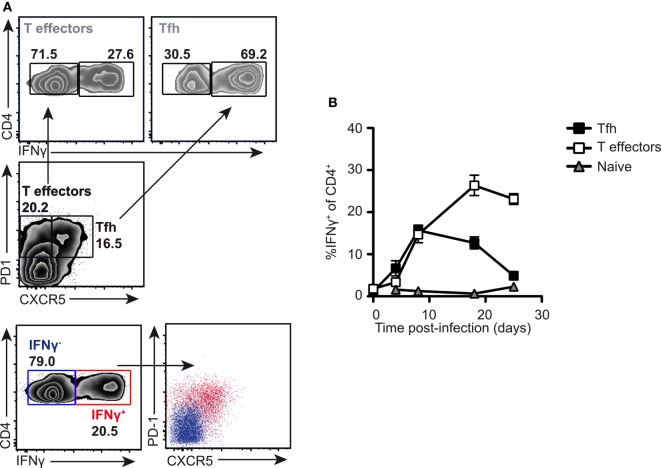
PD1lo T follicular helper cells (Tfh)-like function as effector cells early in response to Salmonella. Analysis of intracellular IFN-γ production in normal mice infected with SL3261. (A) Intracellular staining for IFNγ was performed following PMA and ionomycin stimulation on splenocytes from SL3261-infected animals at day 7. Cells were gated on Tfh (PD1+CXCR5+) versus T effectors (PD1+CXCR5−) and IFN-γ-producing cells among these populations enumerated (top panel). Overlays (lower panel) of IFN-γ producers (red) versus non-producers (blue) revealed that the majority of cytokine positive cells were PD1+CXCR5+. (B) Kinetics of IFN-γ production in splenic CD4 T cells were analyzed. Cells were distinguished by CXCR5 and PD1 expression as Tfh (CXCR5+ PD-1+, black squares), T effectors (CXCR5− PD-1+, white squares), and naive T cells (CXCR5− PD1−, gray triangles). Data points (B) represent mean of n = 5 with error bars SEM. Presented data are representative of three independent experiments.